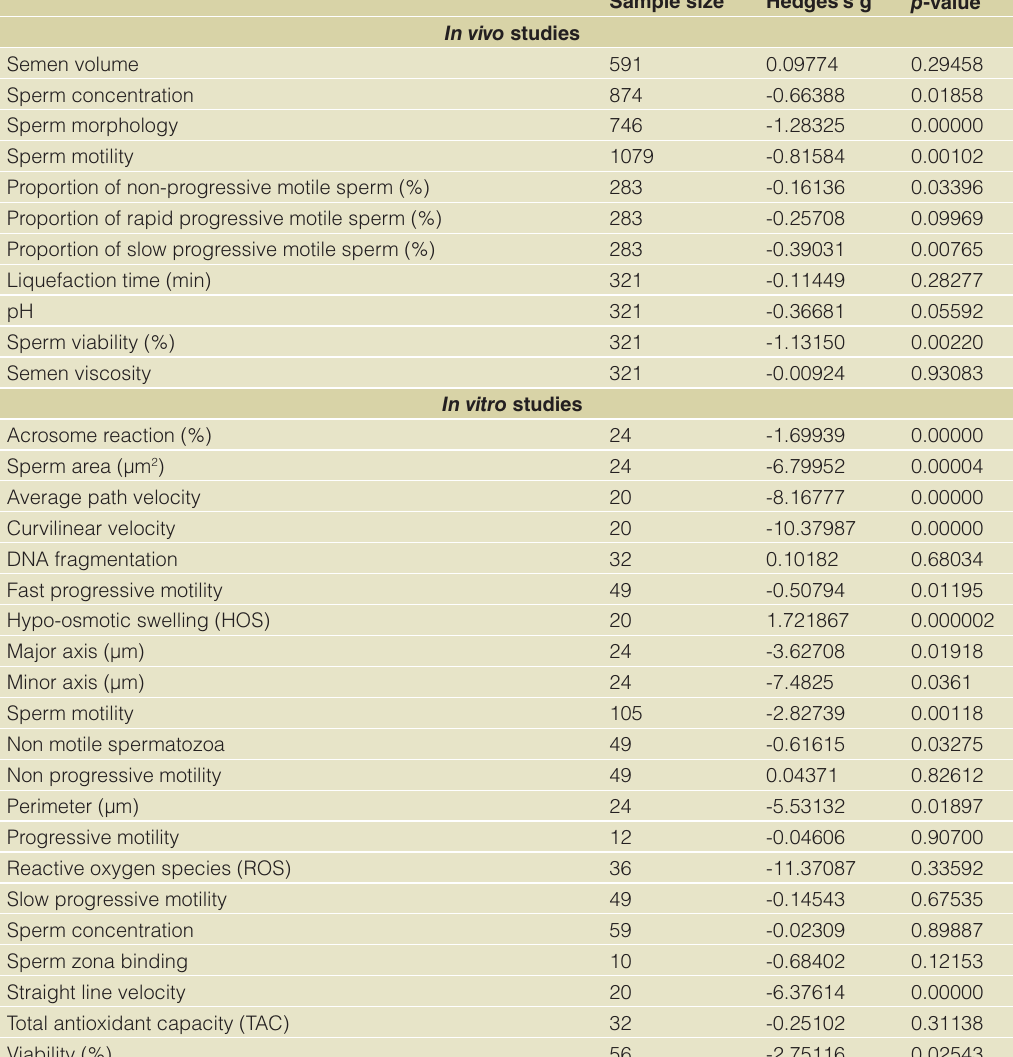
Table 1. Effect sizes of mobile phone radiation on sperm quality